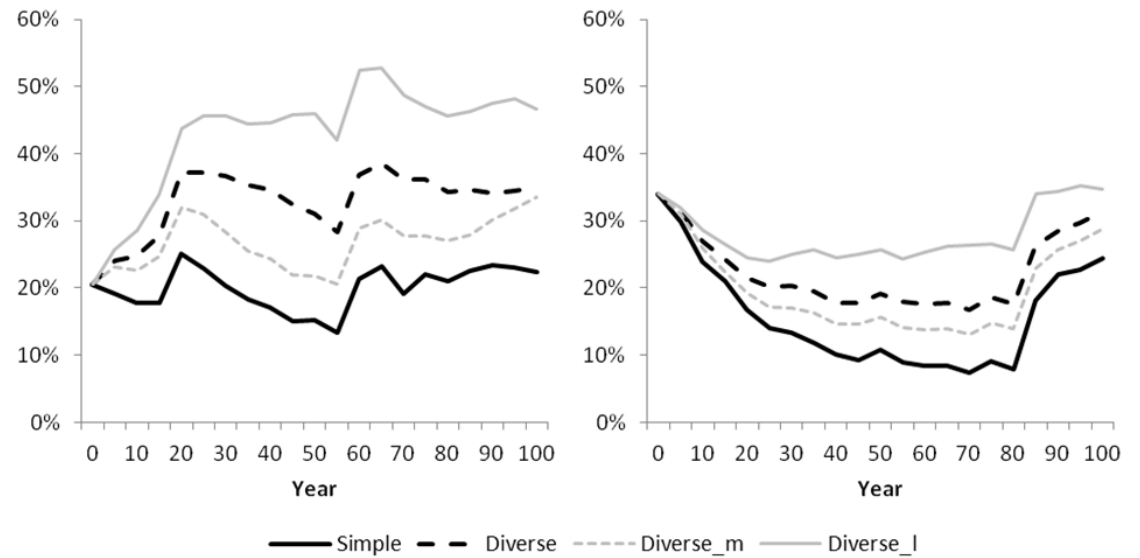
Figure 7. Proportion of mature forest with large proportion of broadleaves, in Hässleholm ( left ) and Vilhelmina ( right ), for the Simple and Diverse scenarios, as well as the more intensive (Diverse_m) and less intensive (Diverse_l) variations of the Diverse